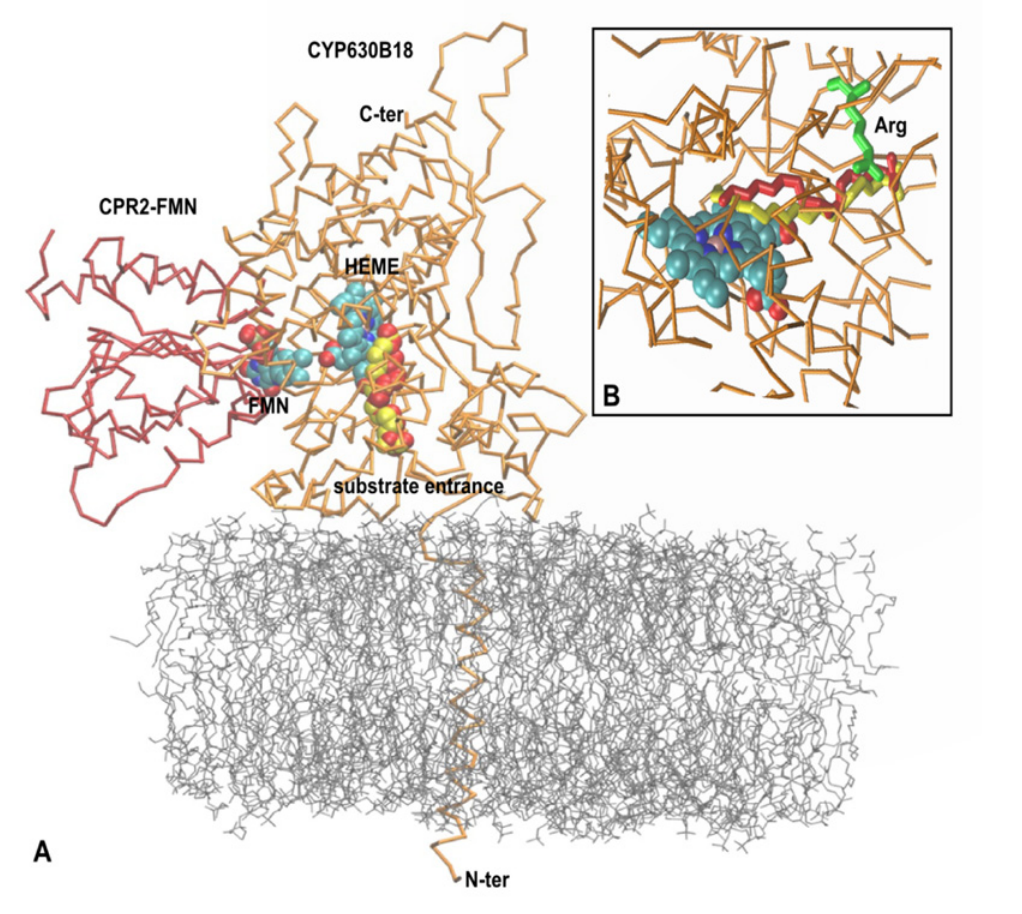
Fig 6. The model of RS2 reconstitution system of the FMN domain (red) of Gs CPR2 and Gs CYP630B18 (orange), its substrate oleic acid (red) and the non-substrate stearic acid (yellow). (A) The FMN-binding domain of Gs CPR2 in open conformation interacts with the Gs CYP630B18 that brings the FMN cofactor in close proximity to the CYP heme cofactor and thus facilitates electron transfer. The Gs CYP630B18 transmembrane region is inserted into the lipid bilayer. (B) Docking of oleic acid (red) versus the stearic acid (yellow) in the active site of Gs CYP630B18. Arginine 224 (green) holds both compounds in the active site